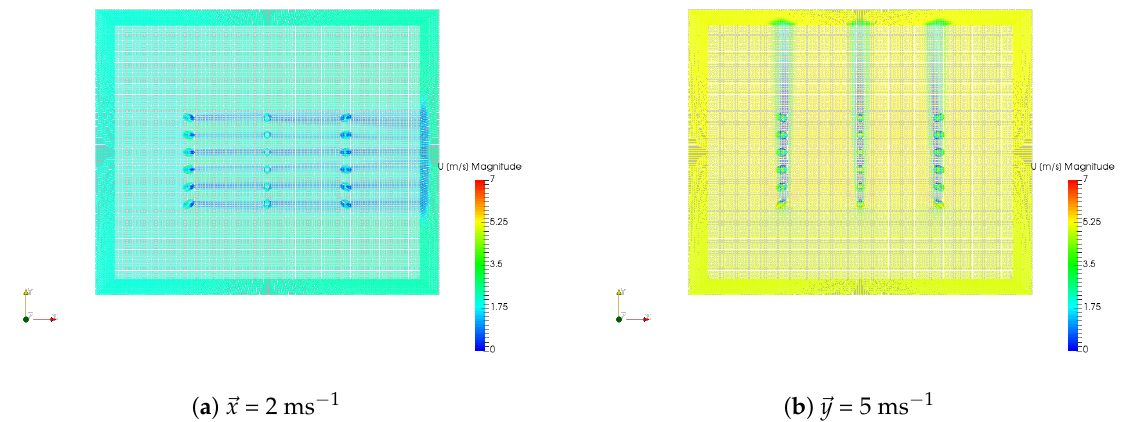
Figure 7. Wind flow simulations used as input for GADEN without considering the rotors’ airflow.